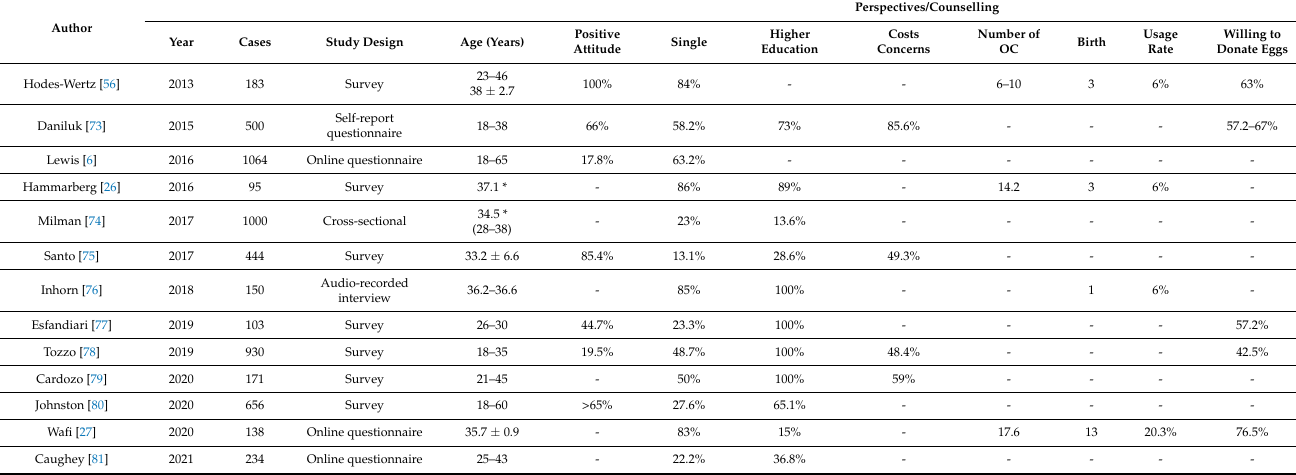
Table 1. Synopsis of studies according to patients’ perspectives and counseling assessment about elective egg